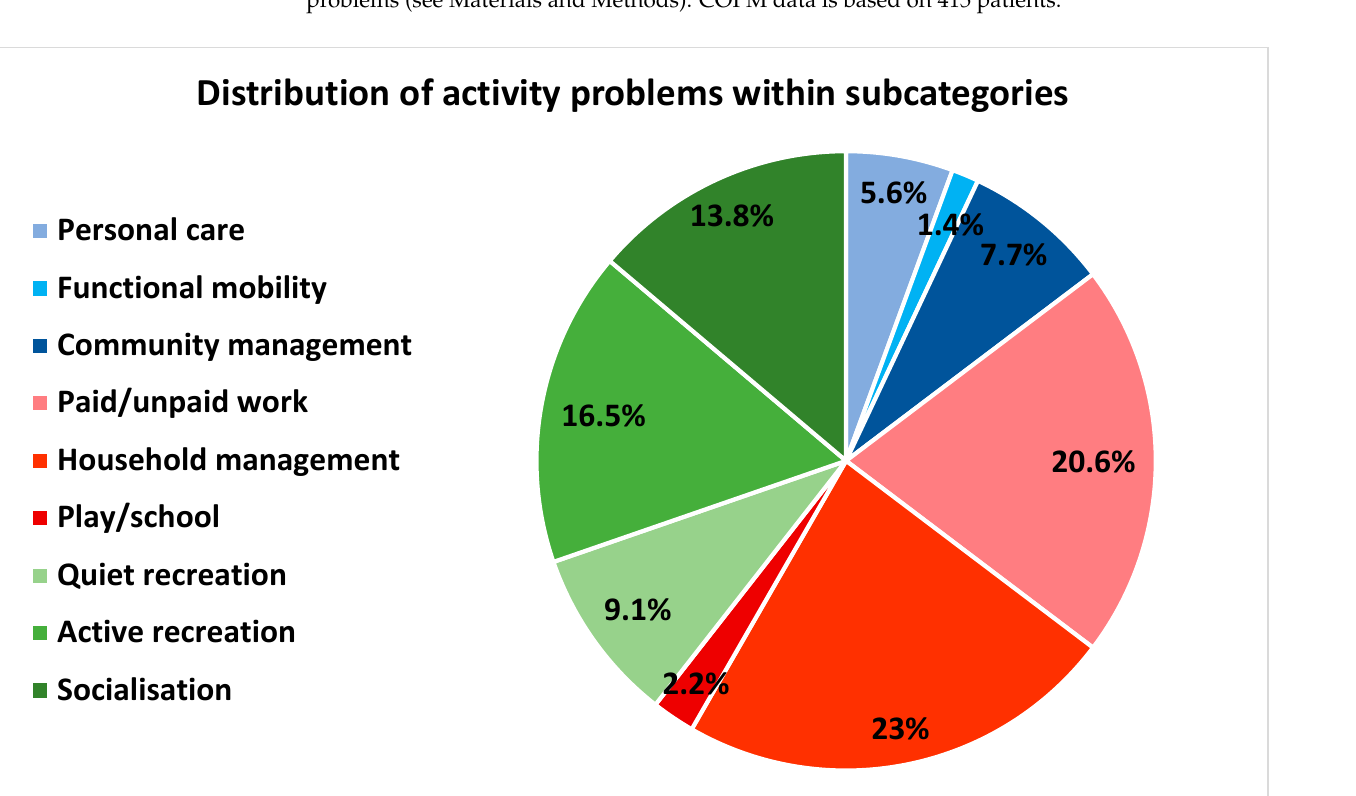
Figure 5. Distribution of prioritised activity problems within overall COPM categories: self-care activities (blue), productive activities (red) and leisure activities (green). Frequency ( n ) and relative frequency (%) of patients reported. Patients were the opportunity to prioritise up to five activity problems (see Materials and Methods). COPM data is based on 415 patients.